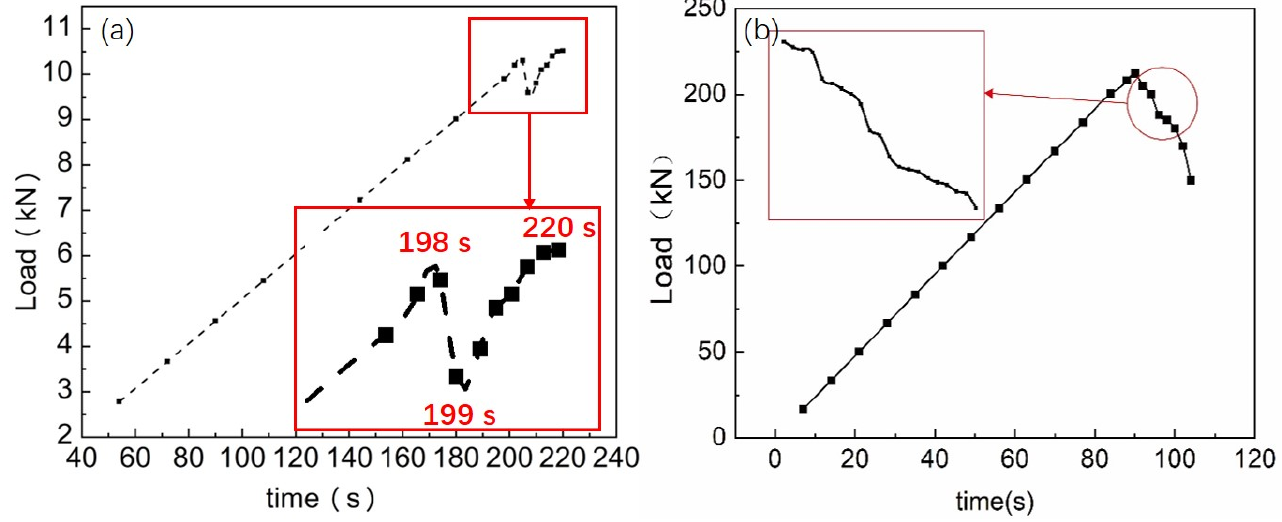
Figure 8. Physical properties of 6 wt.% straight BCSF-reinforced UHPC cured at 28 days during the load-bearing process: ( a ) flexural strength; ( b ) compressive strength.